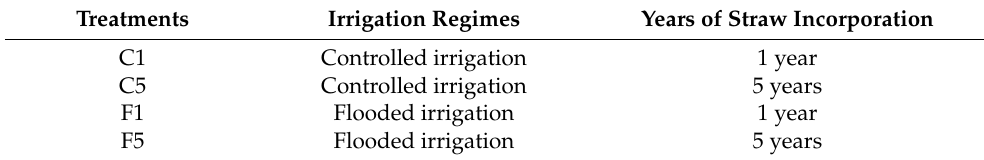
Table 2. Design of the experimental